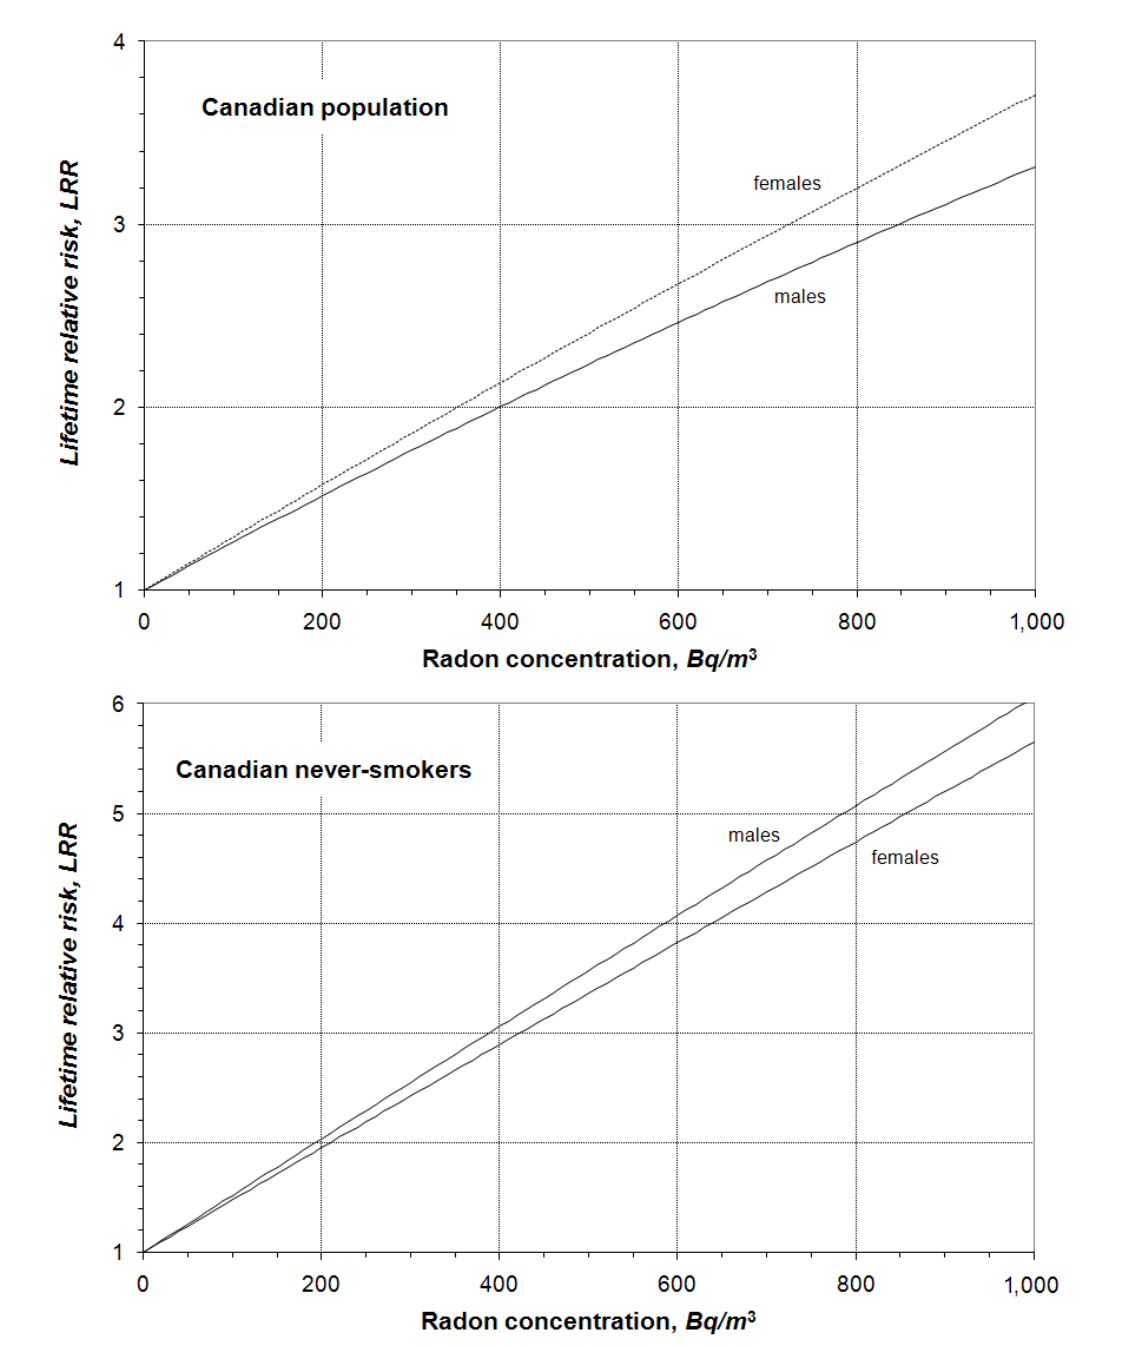
Figure 1. Lifetime relative risks of radon induced lung cancer for lifetime exposure at given radon concentration (upper panel for Canadian population—A mixture of smokers and non-smokers; lower panel for male and female